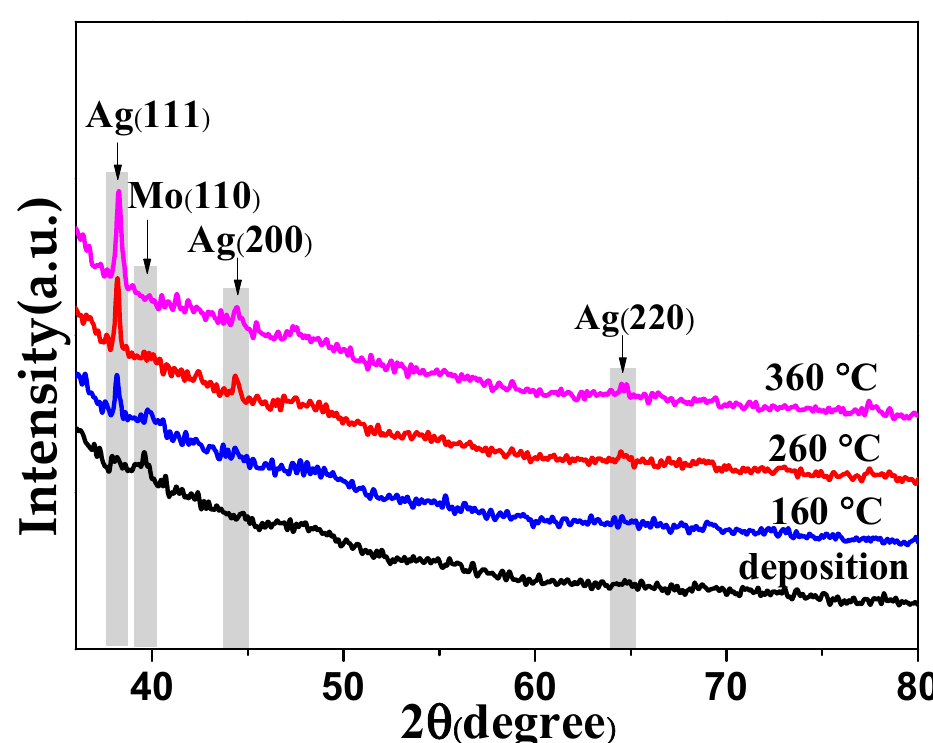
Figure 1. X-ray diffraction (XRD) patterns of the Mo-Ag films before and after annealing. Figure 1. X-ray di ff raction (XRD) patterns of the Mo-Ag films before and after annealing. Table 1. The parameters of crystallites in the films annealed at di ff erent temperatures. Table 1. The parameters of crystallites in the films annealed at different temperatures. Annealing Temperature 2 θ (Degree) β (Degree) D (nm) Annealing Temperature 2 θ (Degree) Room temperature Room